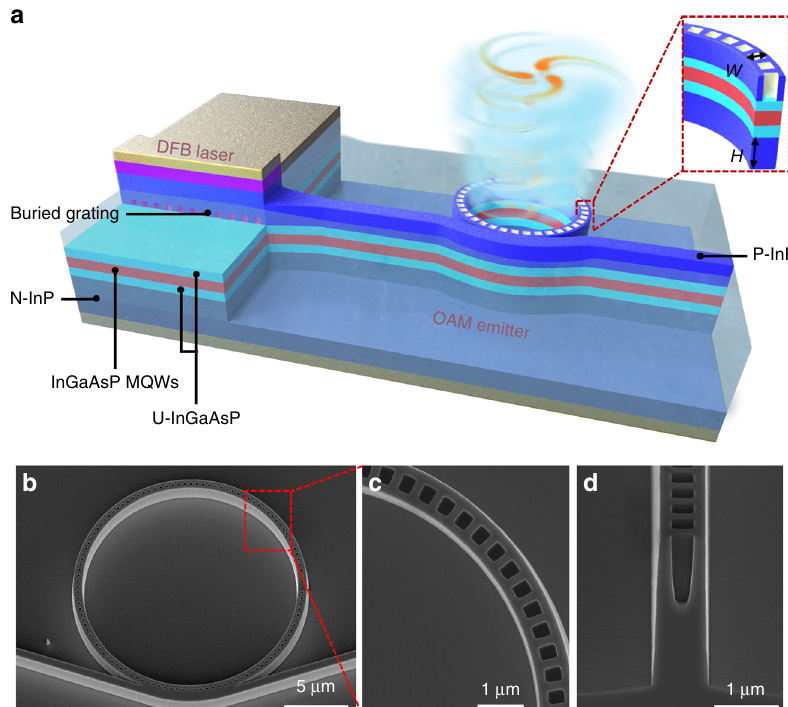
Fig. 1 Integrated orbital angular momentum laser. a Integrated OAM laser with shallow-etched DFB laser and deeply etched vortex emitter on InGaAsP/InP wafer. Inset reveals the cross-section of the vortex emitter. b SEM image of the fabricated OAM emitter. c , d Top and cross-sectional view of the top- grating